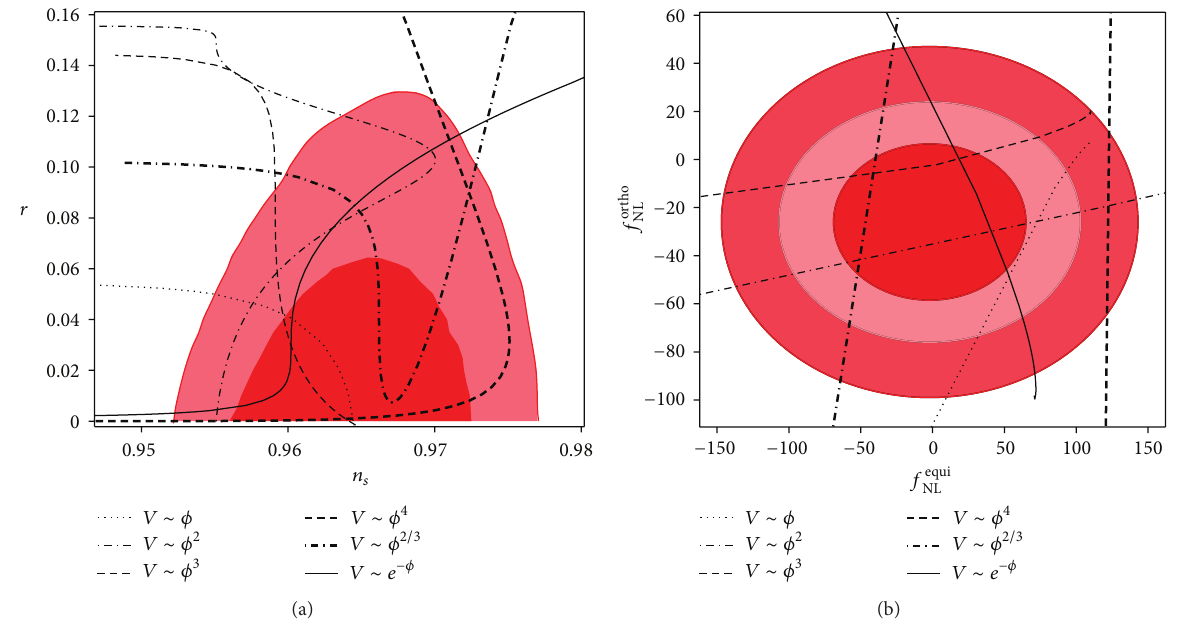
Figure 7: Tensor-to-scalar ratio versus the scalar spectral index for an inflationary model in which both inflaton and its derivative are nonminimally coupled to gravity, in the background of Planck 2015 TT, TE, and EE + lowP data (a) and the amplitude of the orthogonal configuration of non-Gaussianity versus the amplitude of the equilateral configuration for an inflationary model in which both inflaton and its derivative are nonminimally coupled to gravity, in the background of Planck 2015 TTT, EEE, TTE, and EET data (b). Figure is plotted with 𝑛 = 4 , 𝑓(𝜙) ∼ 𝜉𝜙 2 , and various types of potential, for 𝑁 = 60